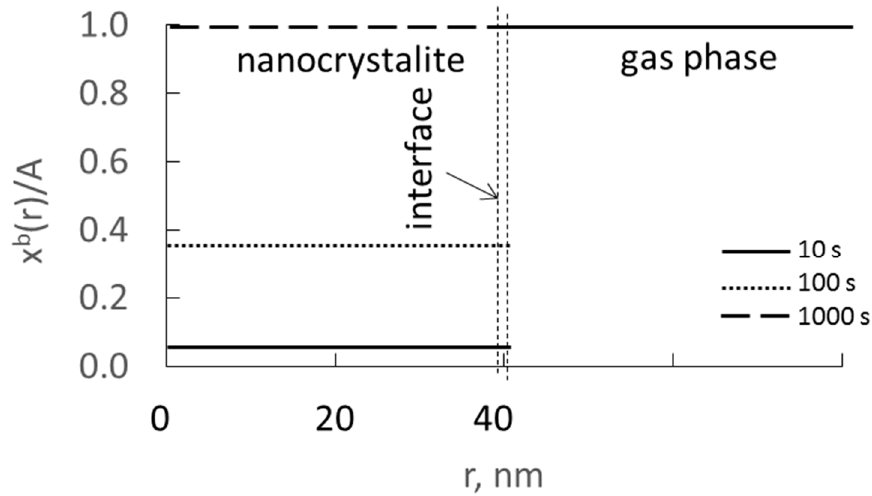
Figure 4. Dependence of nitrogen concentration in nanocrystallite volume (radius 40 nm) on radius and time at a constant surface concentration and with a diffusion coefficient of D = 0.1 nm 2 /s. The rate at which iron nanocrystallite saturates with nitrogen depends on the dif- ference in surface concentration and the concentration in volume of the nanocrystallite according to Fick’s